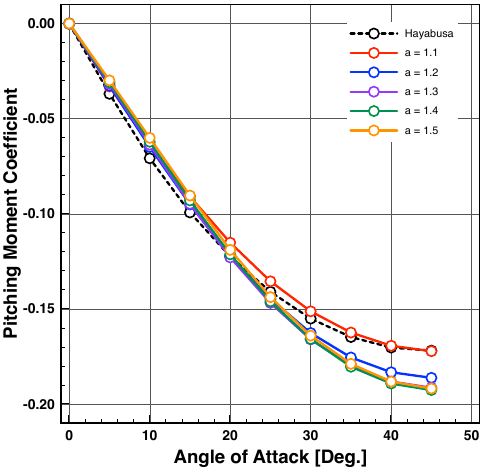
Figure 10. Comparison of the pitching moment coefficient for hyperbolic